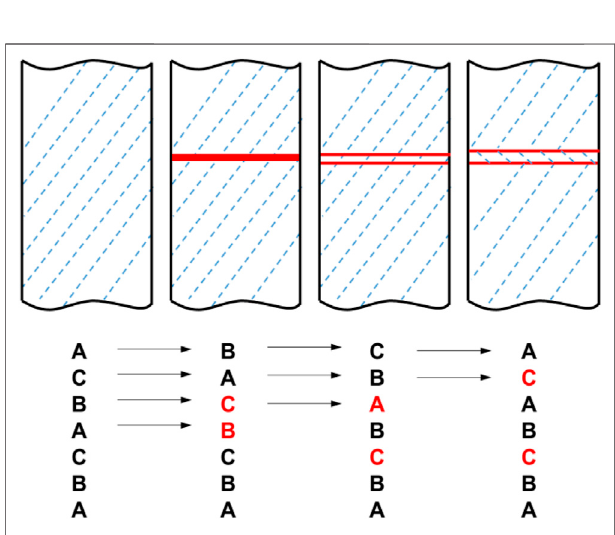
FIGURE 6 | Illustration for the formation of